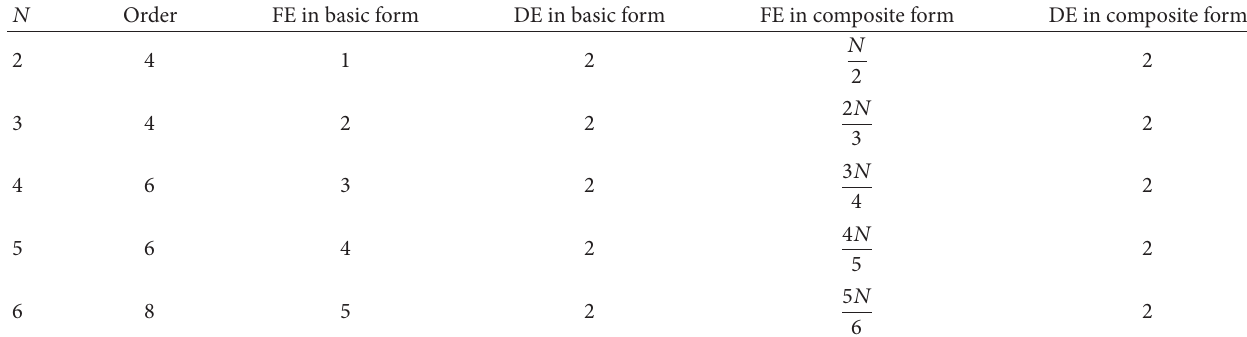
Table 6: Computational cost for